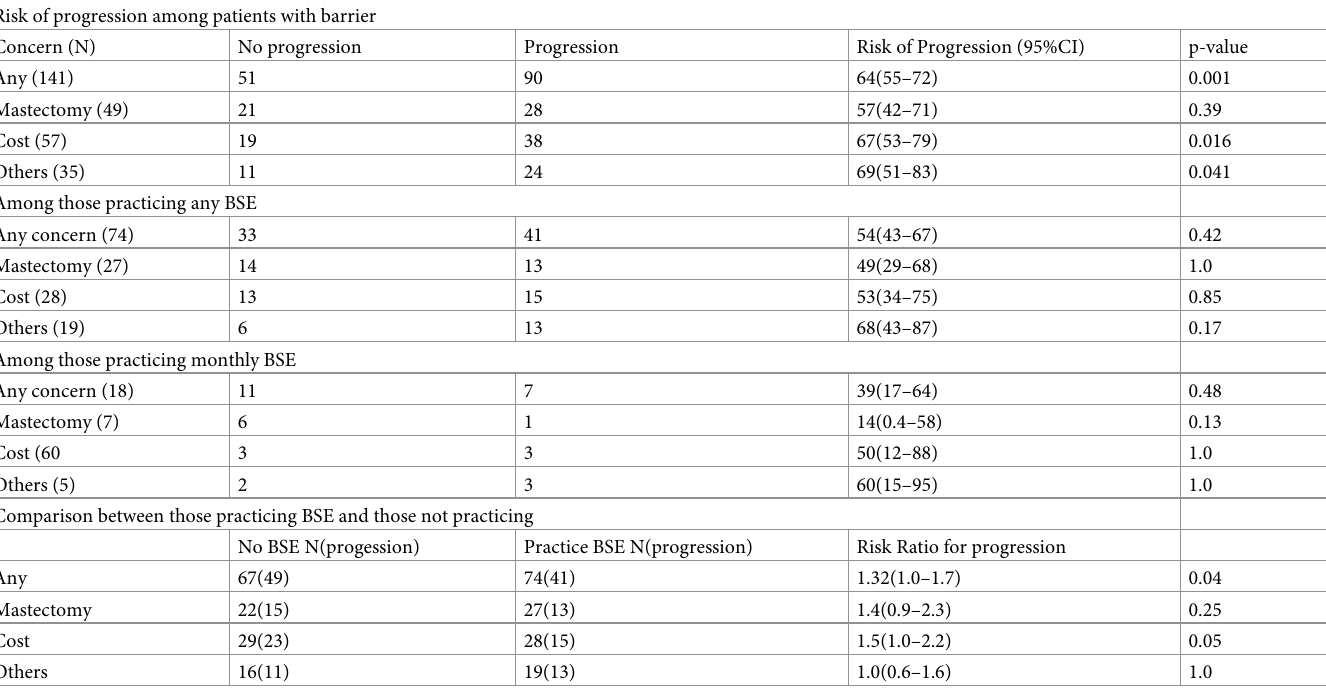
Table 4. Showing interaction between practice of BSE and incidence of progression.